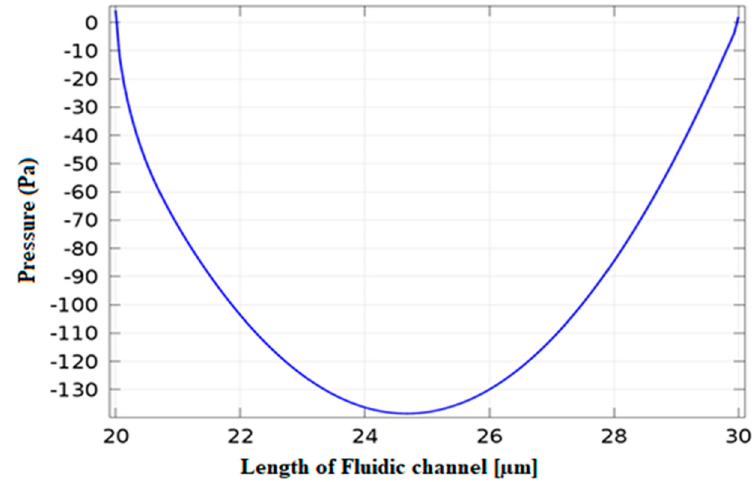
Figure 5. Pressure along the central axis of the channel.